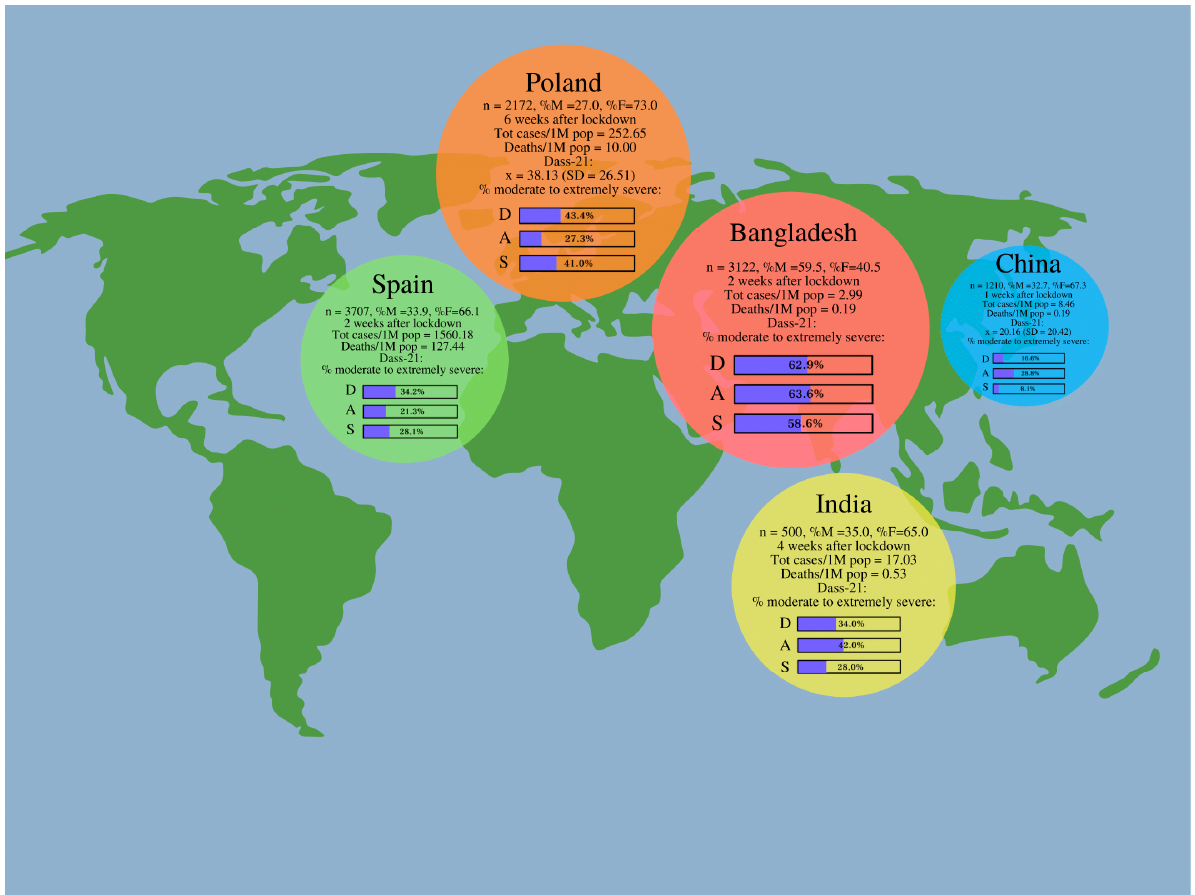
Figure 1. The results of the studies from Poland, Spain, China, India, and Bangladesh performed applying the DASS-21 scale. Legend: n = total number of the respondents, %M = percentage of male respondents, Tot cases/1M pop = total number of cases of COVID-19 per 1 million population on the first day of study, Tot deaths/1M pop = total number of deaths caused by COVID-19 per 1 million population on the first day of study, x = mean score of DASS-21, SD = standard devia- tion, % moderate to extremely severe = percentage of participants with Dass-21 score form moderate to extremely severe for depression (D), anxiety (A), and stress (S).